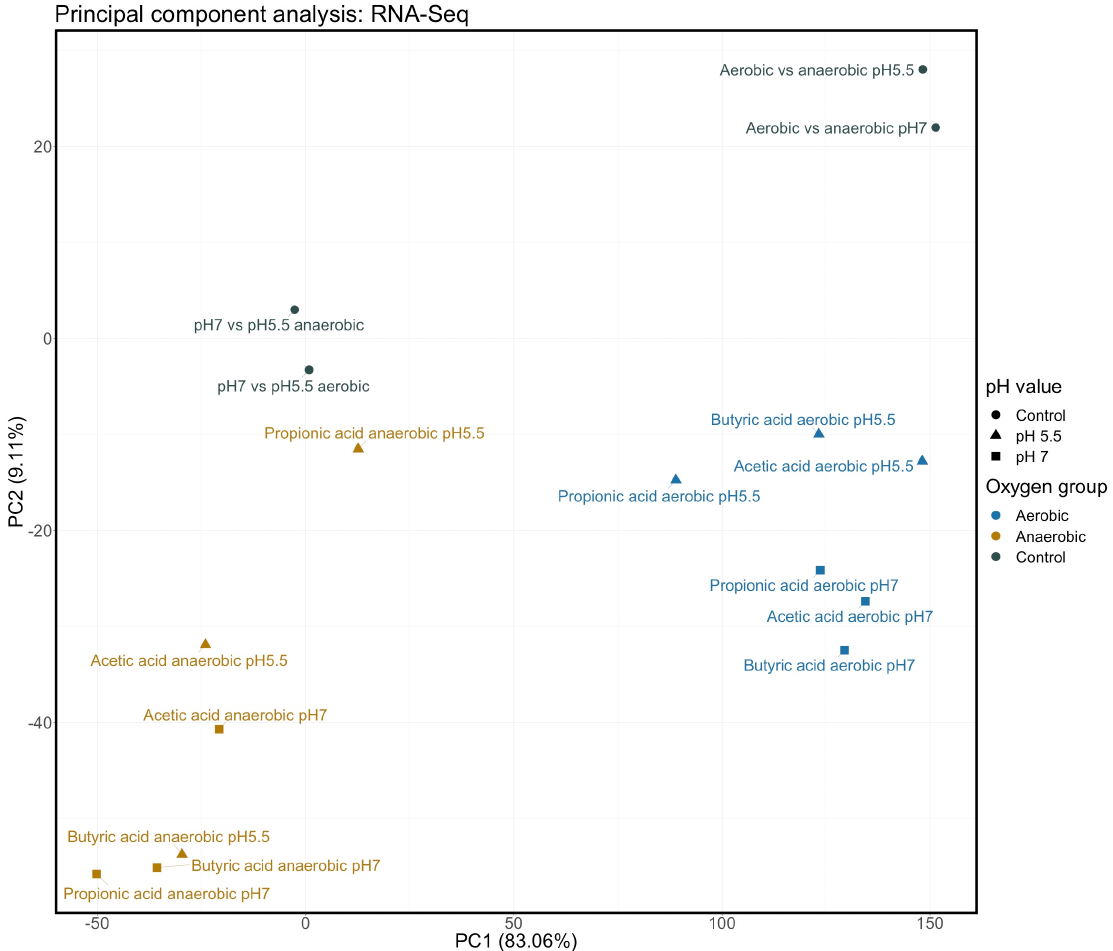
Figure 2. Principle component analysis of RNAseq data. RNAseq data, as used in clustering in Figure 1, were analysed using principle component analysis as described in Materials and Methods. This figure shows the first two components (PC1 and PC2) in this